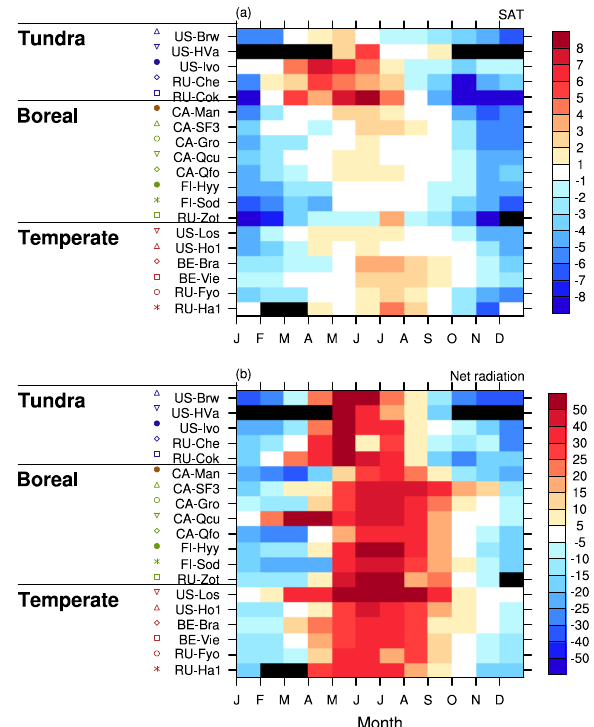
Figure 8. Monthly biases in RASM1 from flux tower observations for (a) 2m surface air temperature SAT ( ◦ C) and (b) net radiation (Wm − 2 ) at CA-Man and all other locations outside of the Manitoba cluster. Black indicates months with no data for that month at that